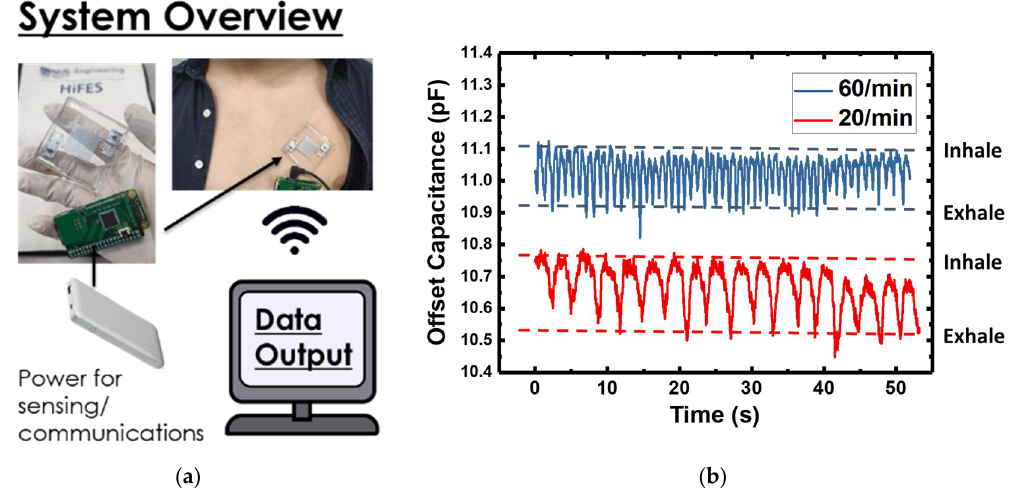
Figure 7 . ( a ) System overview of the respiratory tracker with a photo image of the patch attached to a human chest, and ( b ) time dependence capacitance values measured by the capacitance chip as the human subject was breathing over 50 s. Two different respiratory rates were demonstrated as indicated in the legend.